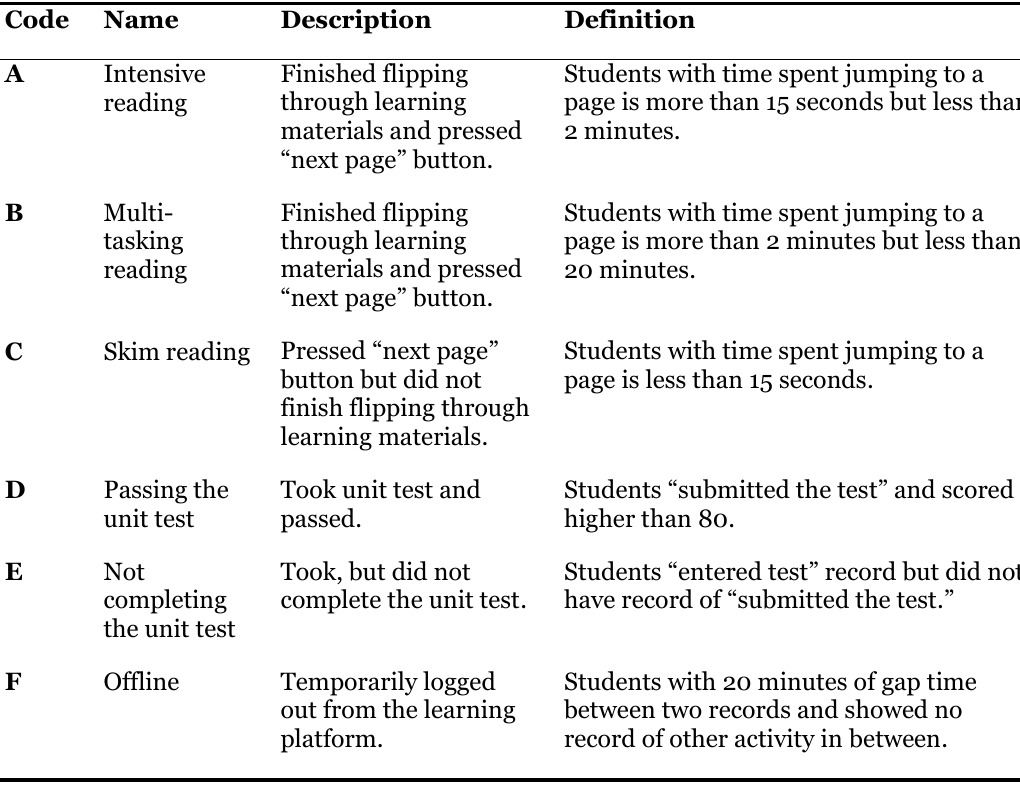
Table 2 Online Reading Behavioral Coding